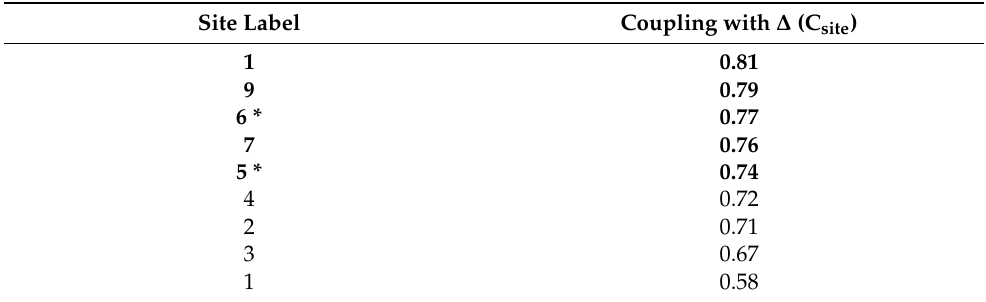
Table 2. Ranking of GCGR sites based on the strength of their coupling to ∆ in normal mode analysis (NMA).